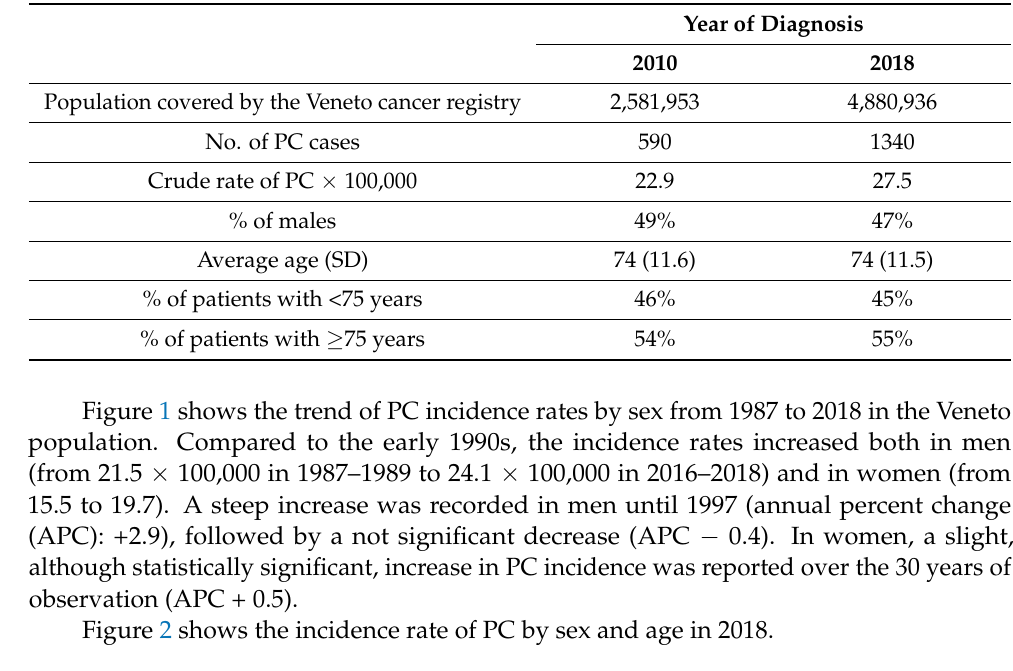
Table 1. Pancreatic cancers (PC) recorded in the Veneto region populations in 2010 and in 2018. Population covered by the Veneto cancer